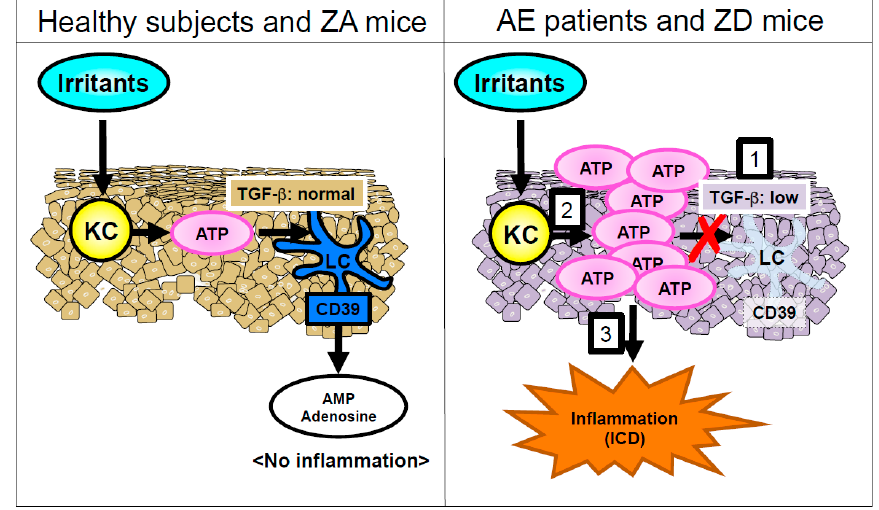
Figure 3. An underlying mechanism of development of acrodermatitis. Right panel: 1. In patients with AE and ZD mice, TGF- β 1 expression in the epidermis is impaired compared with healthy subjects and ZA mice. Subsequently, LCs disappear from the epidermis. LCs are the sole CD39 (ecto-NTPDase1)-expressing cells in the epidermis. 2. Ear epidermis from ZD mice produces much more ATP upon the exposure of irritants than it from ZA mice. Additionally, this ATP is not hydrolyzed because of the absence of CD39-expressing LCs. 3. ATP in the epidermis elicits ICD, followed by the formation of acrodermatitis in AE.